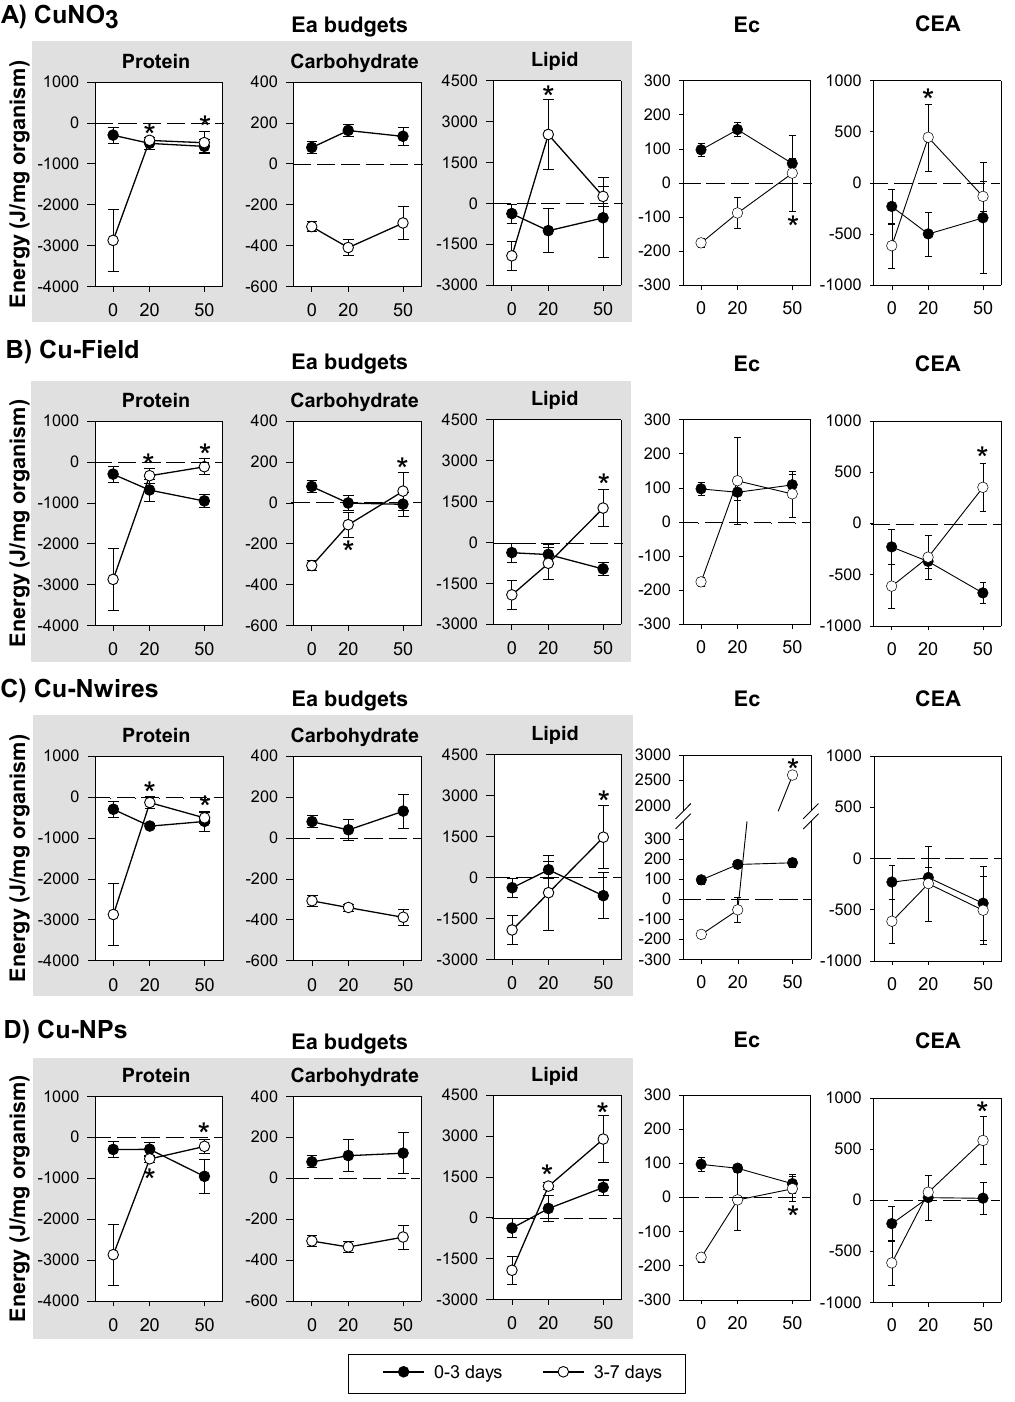
Figure 2. Effects of the reproduction effect concentrations (EC 20 and EC 50 ) of ( A ) copper nitrate—CuNO 3 ; ( B ) copper historical contamination—Cu-Field; ( C ) copper nanowires—Cu-Nwires; and ( D ) copper nanoparticles—Cu-NPs, on the Energy available budgets (Ea: in terms of protein, carbohydrate and lipid budgets), Energy consumption (Ec) and Cellular Energy Allocation (CEA) in Enchytraeus crypticus , within the exposure periods (0–3 and 3–7 days). Results are expressed as average ± standard error. * Dunnett’s test, p < 0.05, for differences between EC x and control within 3–7 days. 0: control, 20: EC 20 , 50:EC 50